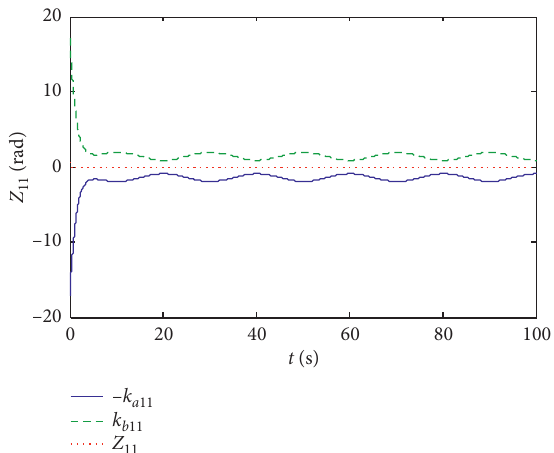
Figure 9: Constraint effect of Z